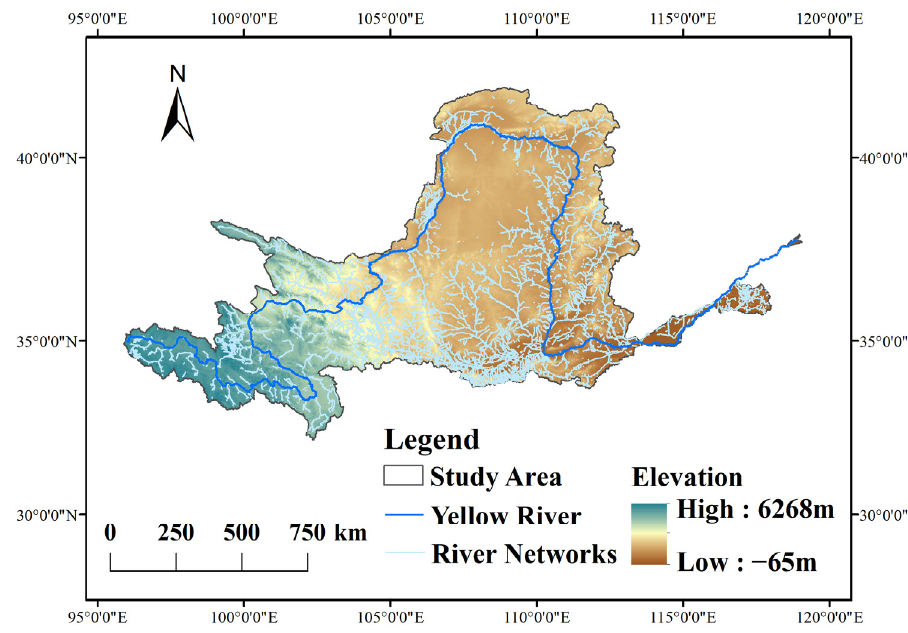
Figure 1. The location of the Yellow River